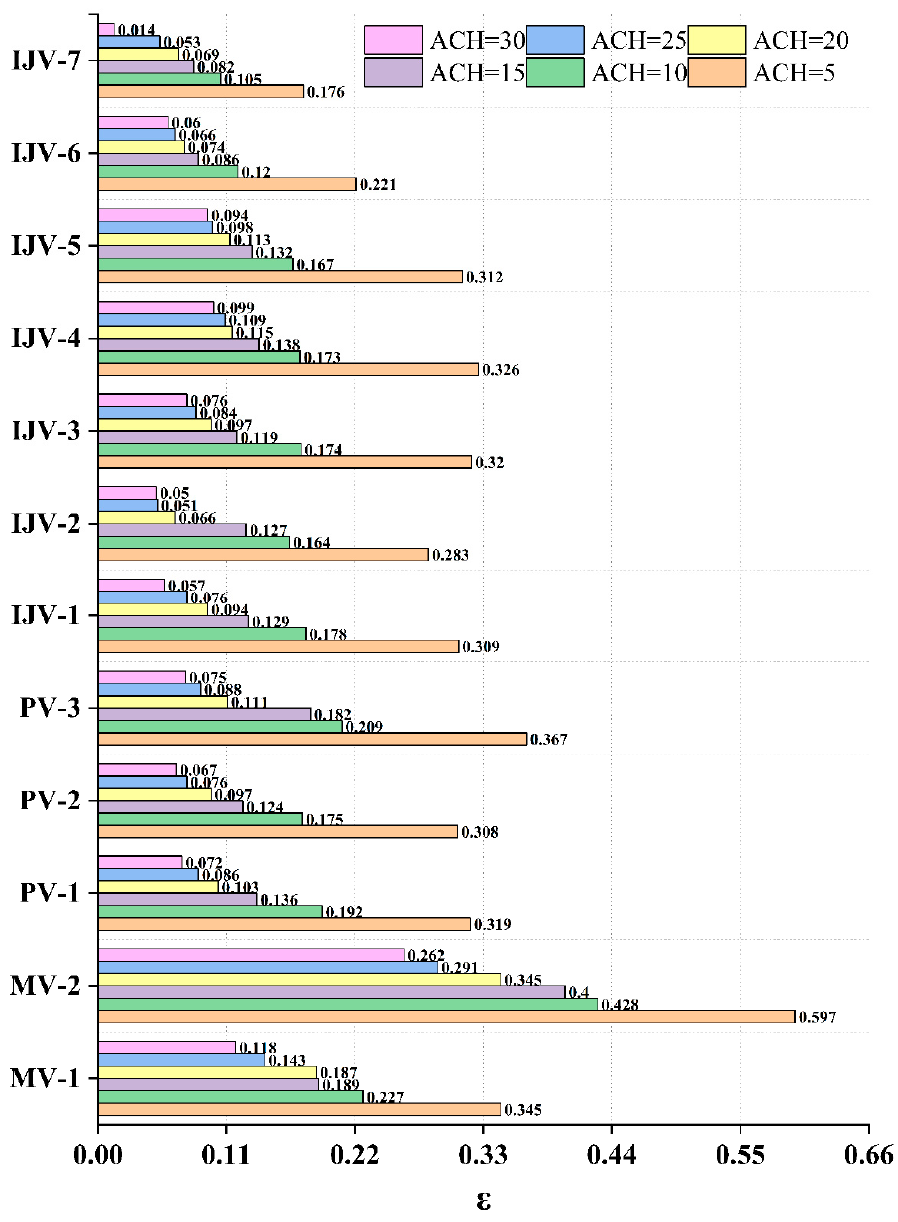
Figure 2. The normalized concentration of ammonia at Z = 1.5 m section. The normalized concentration values of PV-1, PV-2, and PV-3 are 0.319, 0.308, and 0.367, respectively. The air supply positions near the urinals of the three schemes are the same, the air supply positions between the stalls are different, and the air supply position is in the stall. When the door opening is located (PV-2), a better ventilation effect can be obtained. In the PV-1 program, the concentration in the toilet stall and the vicinity of the two urinals are high, and in the rest area is very low (Figure 3c), and the wind speed at the baffle of the toilet in the middle of the toilet is high (Figure 4c); the PV-2 scheme has high concentration near the baffle in the toilet stall and near a urinal, low pollutant concentration in other areas (Figure 3d), and high flow velocity near the air outlet (Figure 4d); the PV-3 program has a high pollutant concentration near the doorway (Figure 3e), the wind speed near the doorway is high, and the wind speed in the rest of the area is low. The position of the air outlet of this program is relatively low, and the airflow velocity of the air outlet has little effect on the monitoring surface speed (Figure 4e).